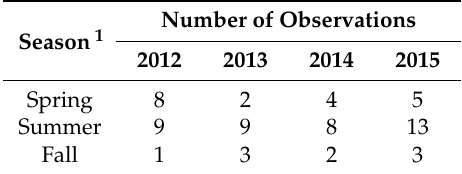
Table A2. Number of GHG sampling events from Monmouth, IL by year and season.